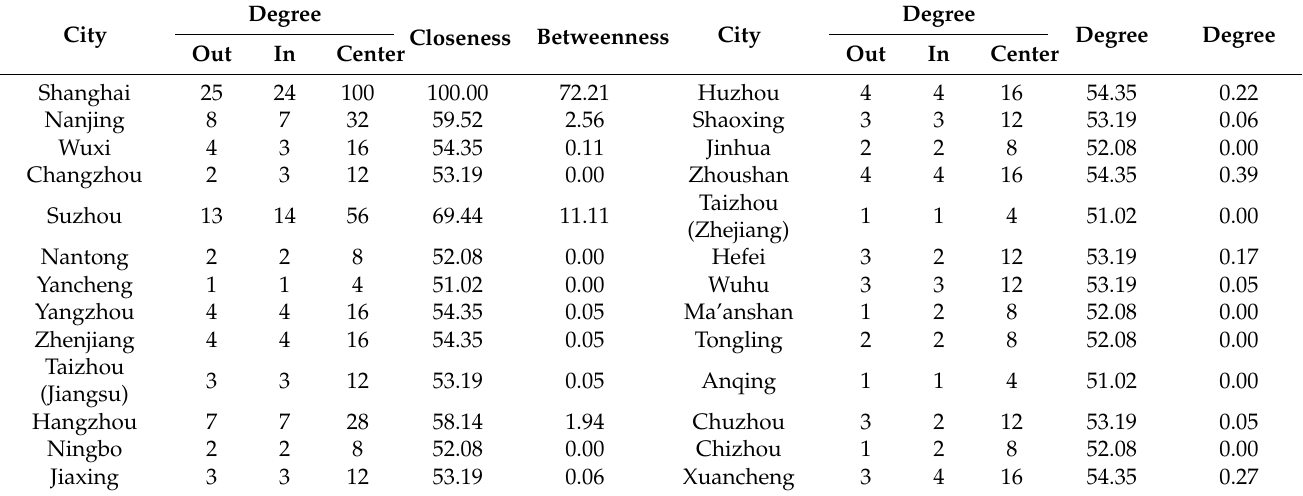
Table 3. Centrality analysis of the spatial correlation network of tourism eco-efficiency in